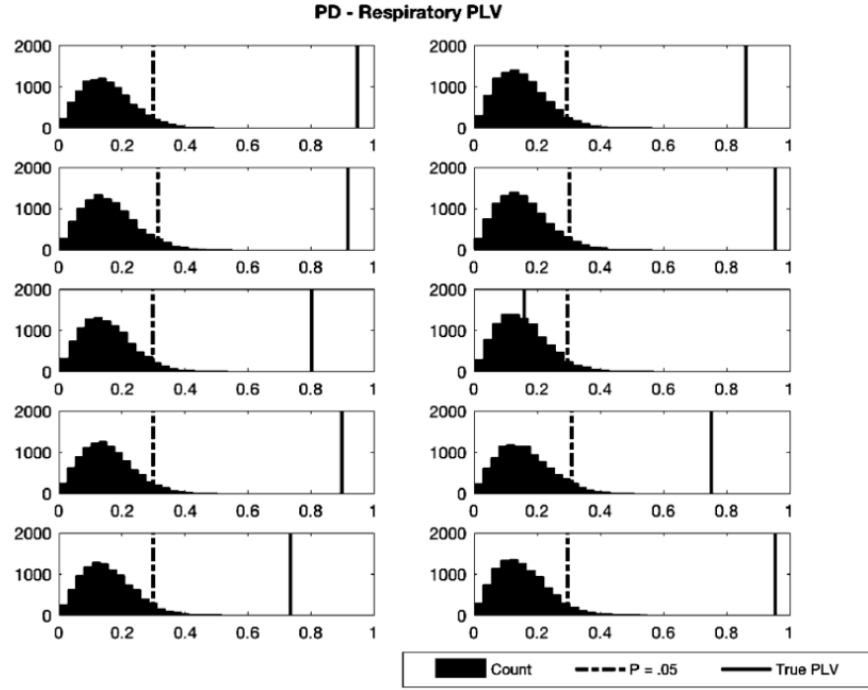
Figure 5. Resampled distributions of PD-respiratory PLVs for 10 participants. Resampling ( n = 10,000) was carried out with replacement under the null hypothesis of no relationship between PD and respiratory phase. Black dotted lines indicate critical values of significance ( p = 0.05) and solid black lines indicate true participant PLV. Vertical axes show counts of resampled distributions, horizontal axes show computed p -values. Table 1. p -values of participant TBR-Respiratory PLVs against resampled (with replacement) distri- butions ( N = 10,000) under the null hypothesis that respiratory phase, which was randomized during resampling, bore no relationship to TBR. Harmonic Mean p -value ( ˇ P ) was calculated by the